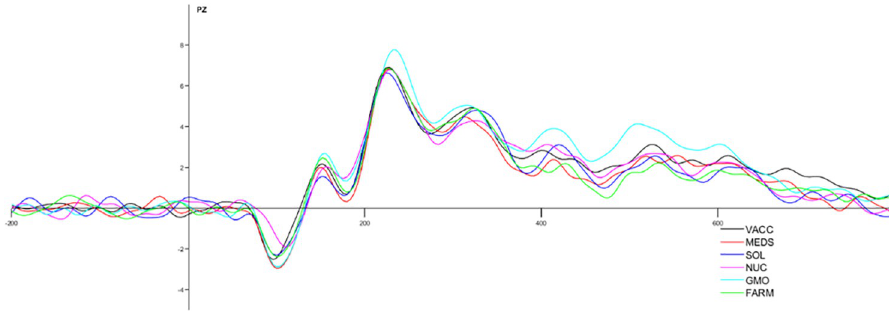
Fig 4. ERP waveform to prime-words for six conditions presented during the study on the PZ. VACC = vaccination, NUC = nuclear energy, GMO = GMO technology, MEDS = medicines, SOL = solar energy, FARM = natural